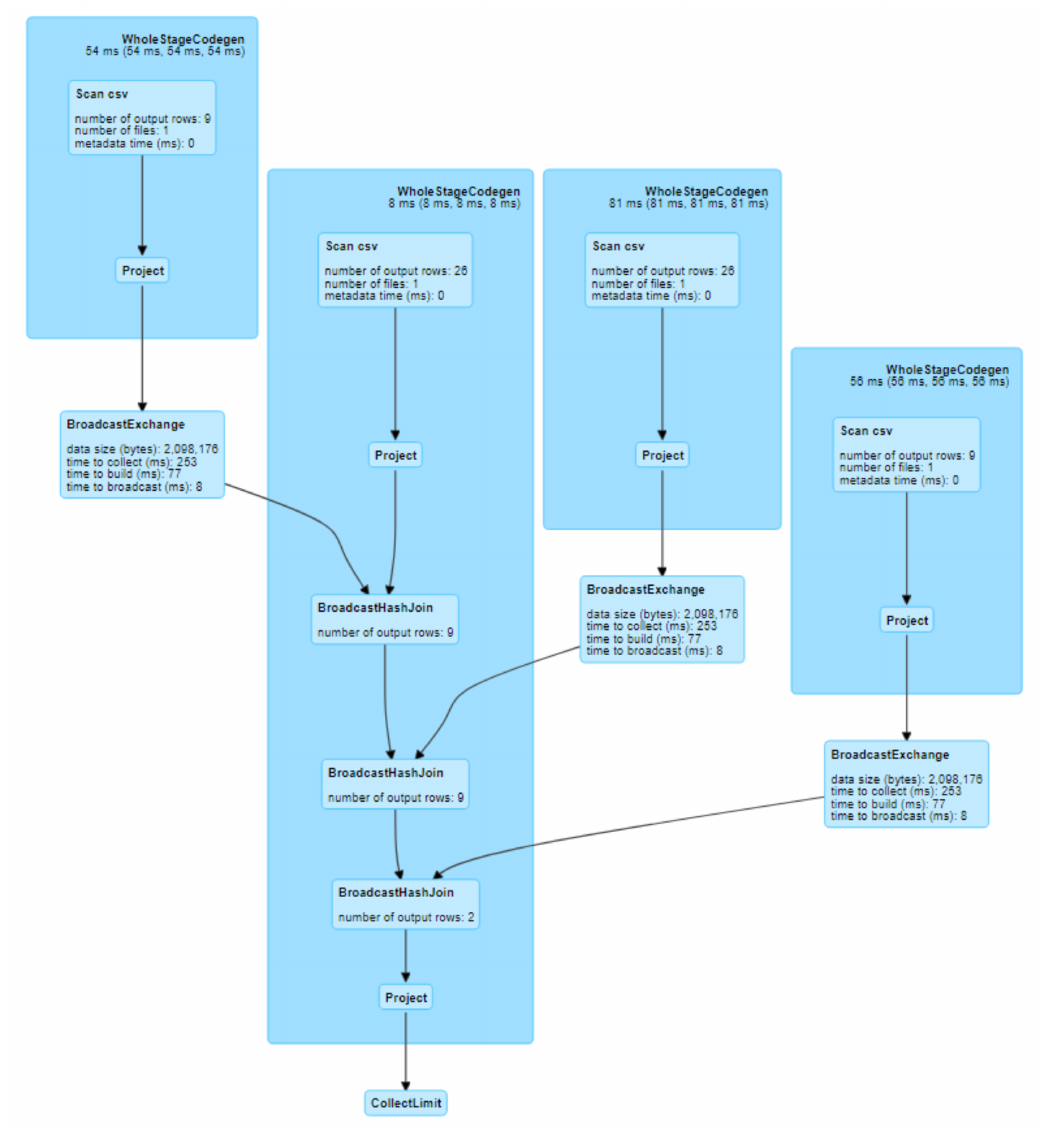
Figure 4. The DAG of motif finding of SCC from g1,